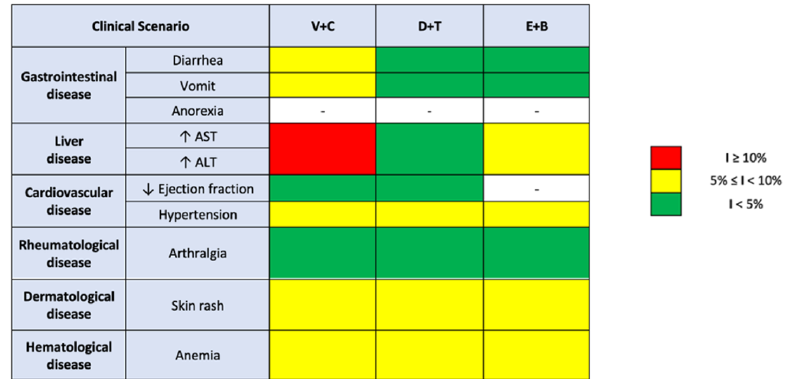
Figure 8. Therapeutic hypotheses amongst the three pharmacological doublets (V + C: Vemurafenib plus Cobimetinib; D + T: Dabrafenib plus Trametinib; E + B: Encorafenib plus Binimetinib) under analysis, considering the clinical scenario and the grade 3–5 side effects’ incidence (I). Supplementary Materials: The following supporting information can be downloaded at: www.mdpi.com/article/10.3390/cancers15010141/s1, Table S1: The 91 studies included in the meta- analysis. Table S2: Evaluation of the bias risk according to Risk of Bias in Non-randomized Studies of Interventions guidelines (ROBINS I) [110]. Table S3: Adverse events grade 5; Figure S1: Overall incidences of grade 5 adverse events according to treatment regimen.